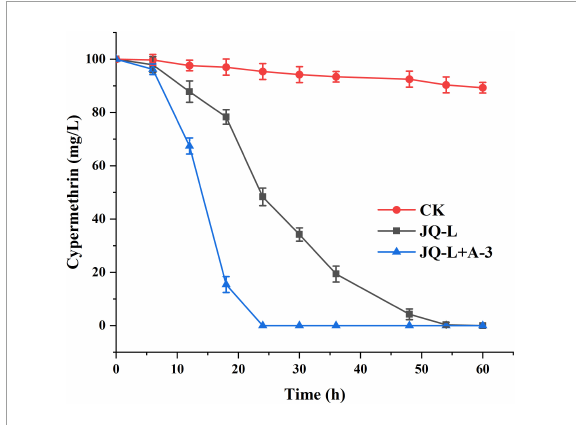
FIGURE5 Time course curve of cypermethrin degradation by co-culture of JQ-L and